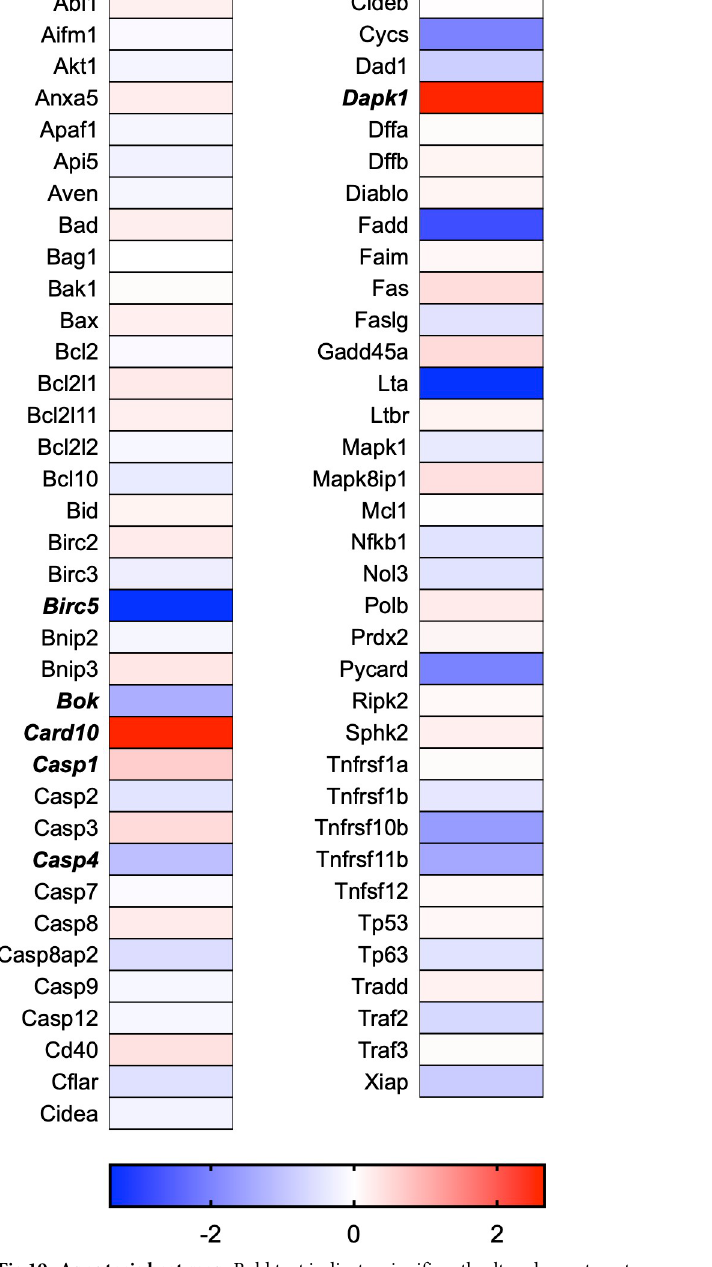
Fig 19. Apoptosis heat map. Bold text indicates significantly altered gene